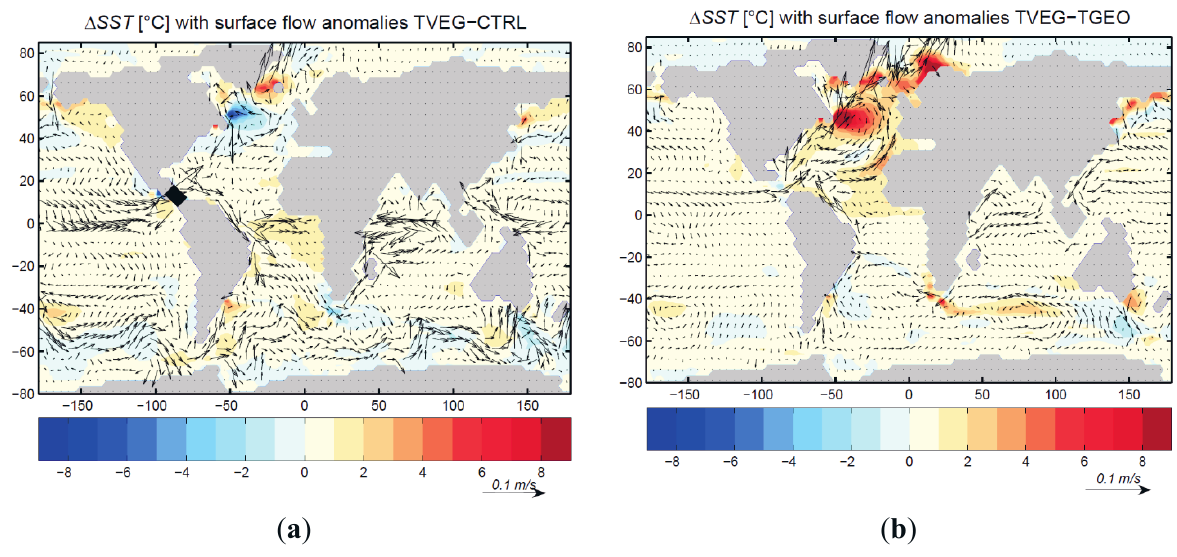
Figure 9. Modeled sea surface temperature anomalies [°C] and surface flow [m/s]. ( a ) Difference between TVEG and CTRL; ( b ) difference between TVEG and